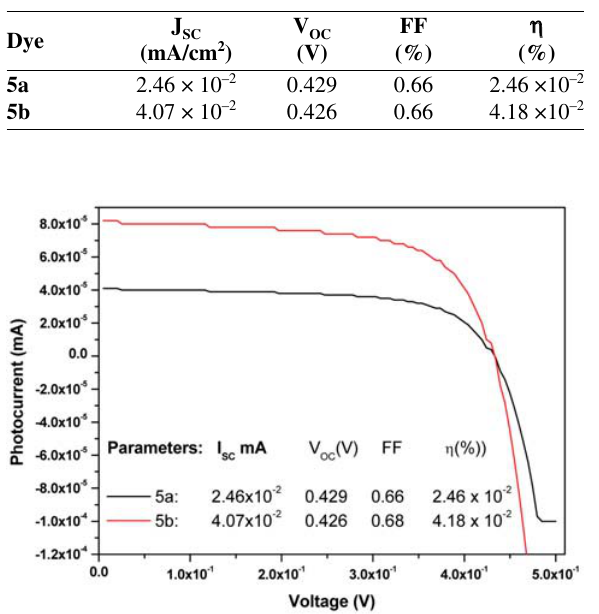
Figure 4. J-V characteristics of the DSSCs fabricated from dyes 5a and 5b